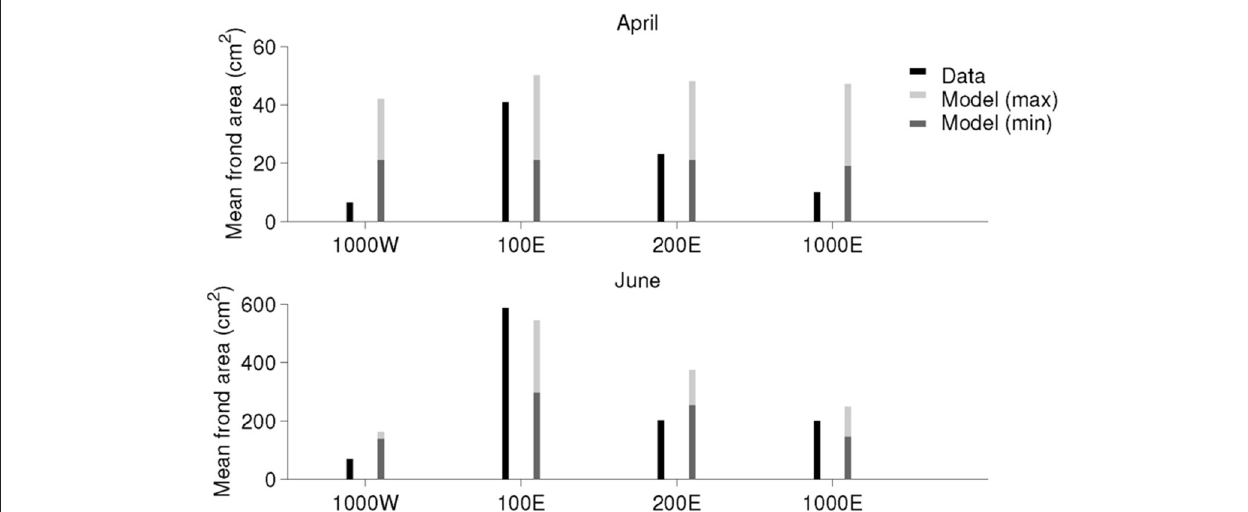
FIGURE 5 | Comparison between simulated and measured frond area values at the four stations (ordered from West to East) on 11th of April (Top) and 11th of June (Bottom) . The black stems to the left represent the values estimated from measured frond length and width. The dark gray stems to the right represent the spatial average (3 model grid cells, representing the spatial extent of a kelp long line) of simulated frond areas at 5m depth 7 days before the sampling dates (4 April and 4 June). The light gray stems represent the same spatial averages 7 days after the sampling dates (18 April and 18 June).